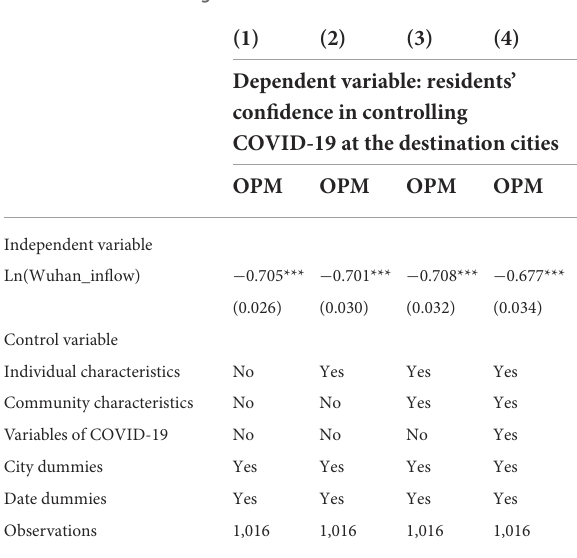
TABLE 4 The impact of inflow of people from Wuhan city on residents’ confidence in controlling COVID-19 outbreak at the destination cities.